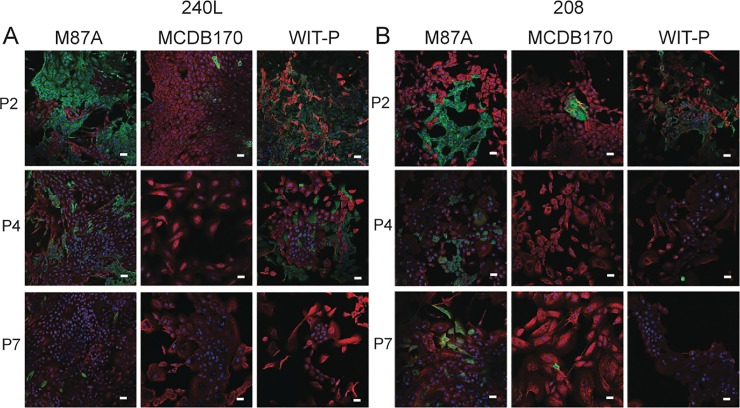
Immunofluorescence assessment of epithelial lineages in pre-stasis HMEC cultures.Cultures generated from specimens (A) 240L and (B) 208 were stained to detect expression of (K)eratin 14 (red), K19 (green), and DAPI (blue). Representative images are shown from passage 2, 4, and 7 HMEC grown in M87A, MCDB 170, and WIT-P media. Magnification bars represent 100μm.